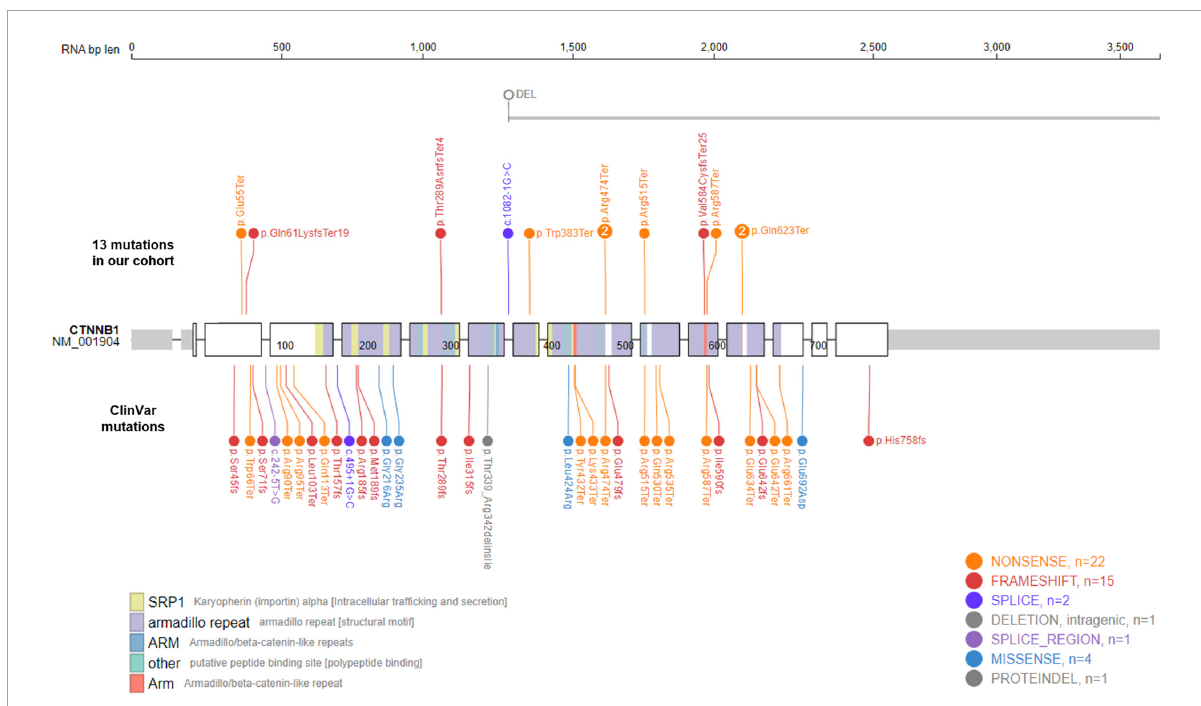
FIGURE1 Mutational spectrum of CTNNB1 -related neurodevelopmental disorder. Eleven de novo CTNNB1 variants were identified in in 13 patients. Two mutations, c.1867C > T (p.Gln623Ter) and c.1420C > T (p.Arg474Ter), were found in two unrelated patients, respectively. The large deletion of Case 4 spans at least 685 kb including exons 8–15 of CTNNB1 (NM_001904). We also visualized 33 de novo ClinVar mutations in CTNNB1 together, all of which are predicted to be pathogenic or likely